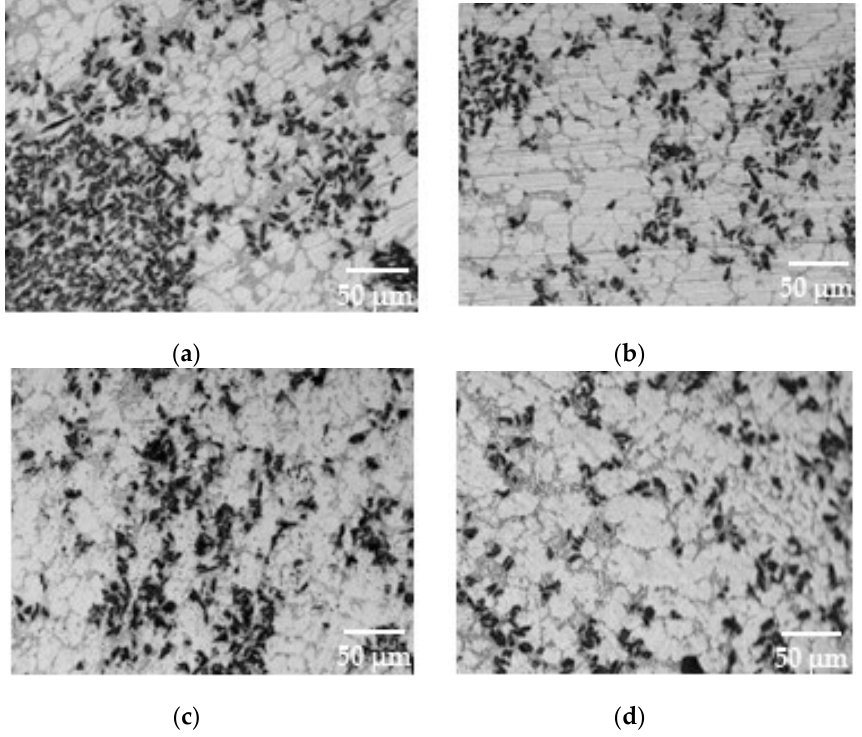
Figure 12. Cross - sectional microstructures of rheo - die-cast A356 / SiC ( 15%SiC - 15µm ) at Speed = 3 m / s and Pressure = 12 MPa in ( a ) position no . 1; ( b ) position no . 2; ( c ) position no . 3; and ( d ) position no . 4 .